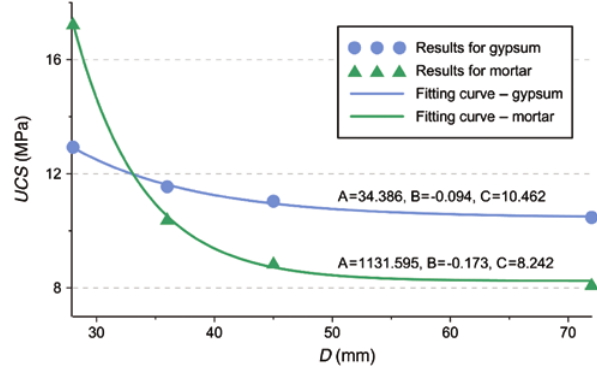
Table 3: The results of laboratory investigations for gypsum speci- mens of different diameter D .